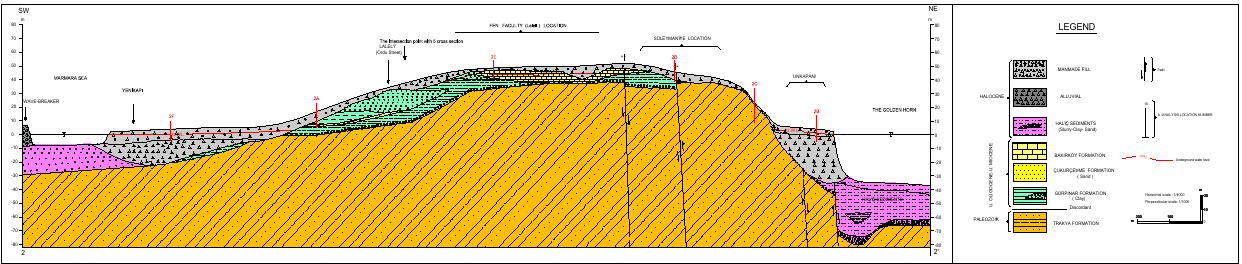
0 cross section where the 1-D and 2-D analyses were performed (Ince et al., 2008). Figure 4. The location of the points on the 2-2’cross section where the 1D and 2D analyses were performed (Ince et. al., 2008) Figure 4. The location of the points on the 2-2